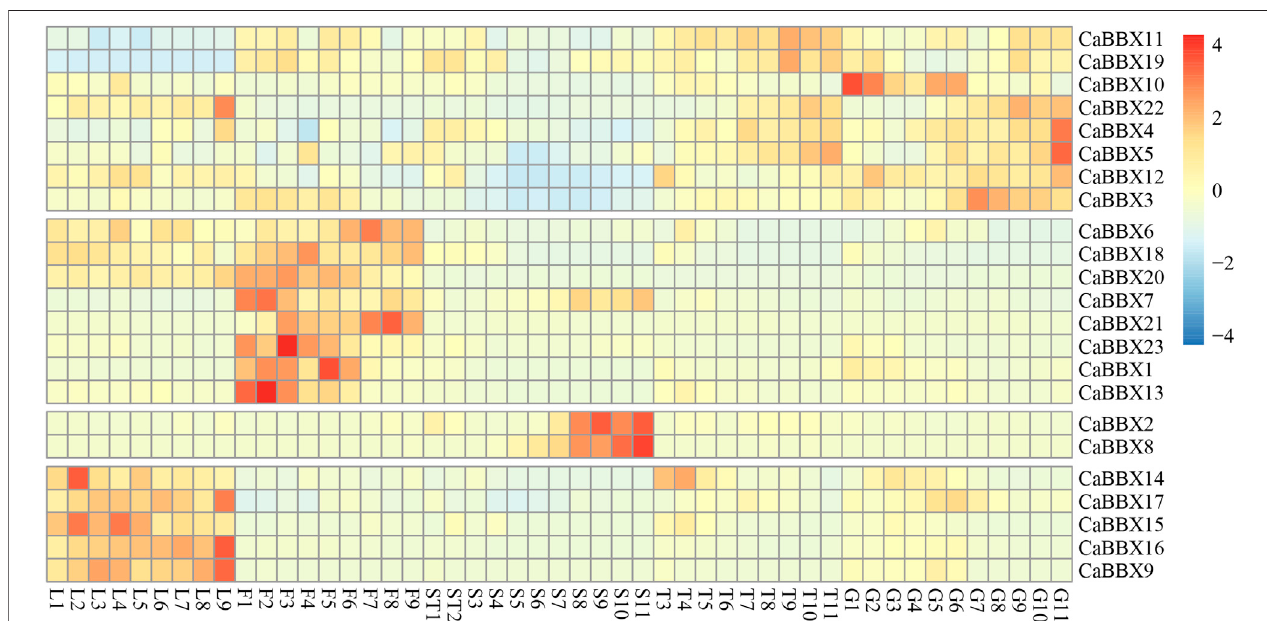
FIGURE 4 | A Expression patterns of CaBBXs . Expression pro fi les using RNA-seq fragments per kilobase million (FPKM) data in the leaves between ten DAP and 60 DAP (L1 – L9), fl owers between ten DAP and 50 DAP (F1-F9), placenta and seed between ten DAP and 15 DAP (ST1 and ST2), theplacentabetween 20 DAP and 60 DAP (T3 – T10), and pericarp between ten DAP and 60 DAP (G1 – G11).